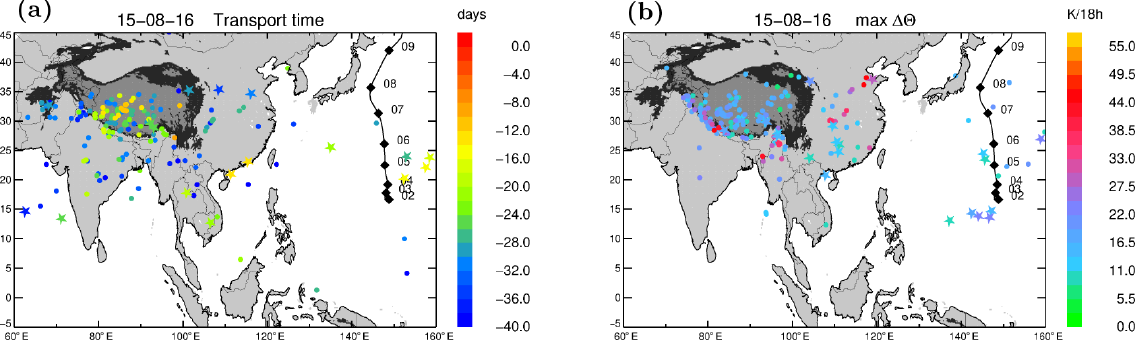
Figure 9. As Fig. 6 but for the no ATAL case on 15 August 2016. Locations of end points and locations of the strongest updraft of trajectories initialised within the cirrus cloud are indicated by star symbols. The 40-day backward trajectories are impacted by Typhoon Omais. Its storm track is shown (black line), and the location at noontime is additionally marked (black diamonds); the numbers indicate the day in August